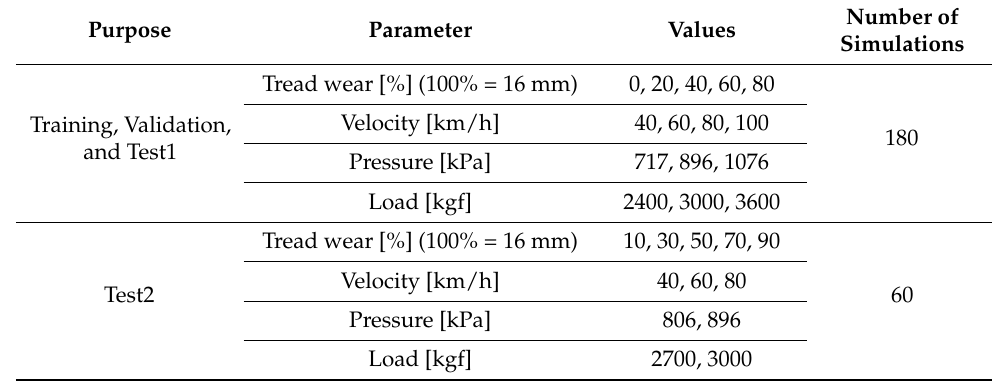
Table 1. Simulation parameters for training machine learning algorithms for tire wear prediction.